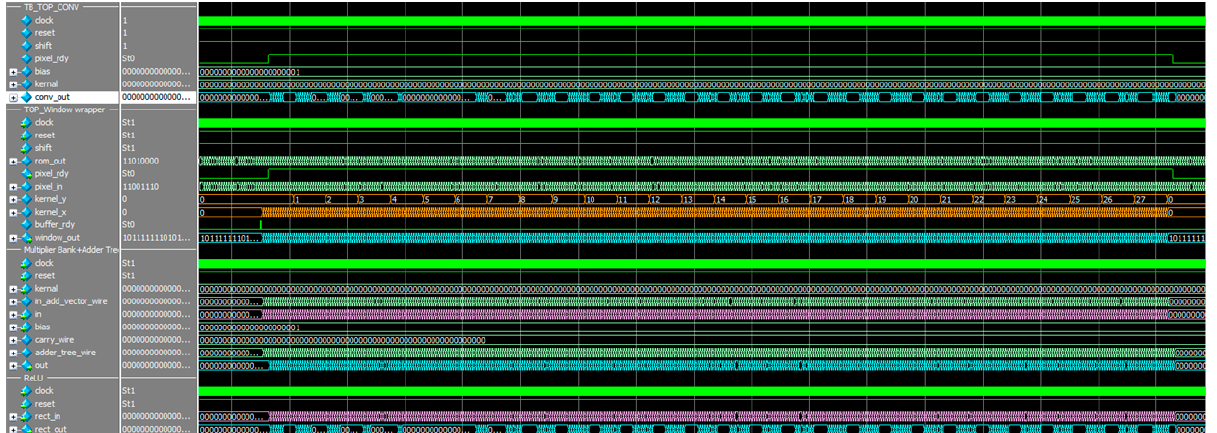
Figure 14. The classification result of the proposed CNN model.